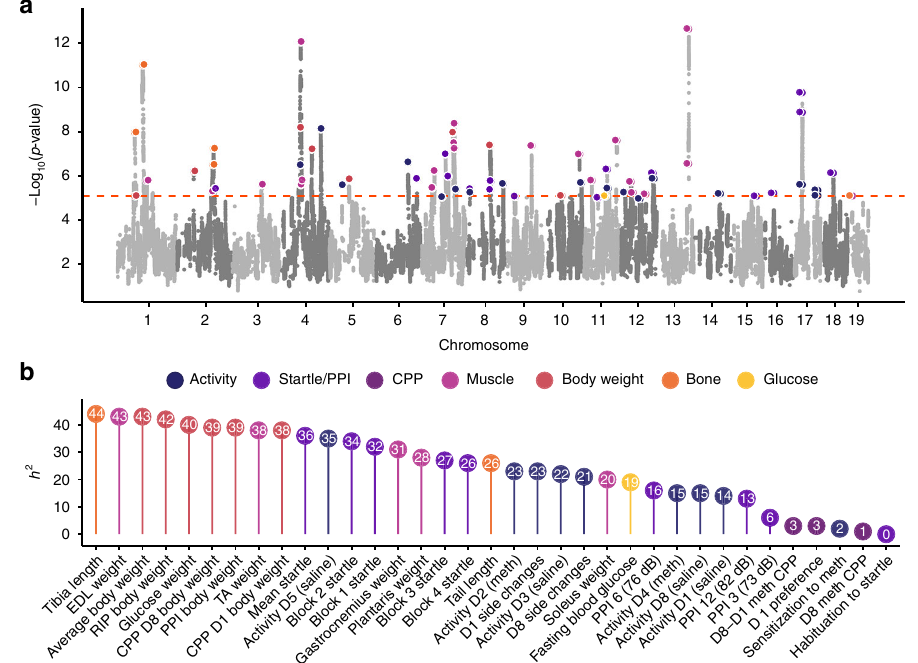
Fig. 3 Manhattan plot and heritability for 120 traits measured in the LG × SM AIL. We identi fi ed 126 loci for behavioral and physiological traits using 1063 mice from G50 – 56 of the LG × SM AIL. A Manhattan plot of GWAS results is shown in ( a ). Associations for related traits are grouped by color. For clarity, related traits that mapped to the same locus (Supplementary Data 1) are highlighted only once. The dashed line indicates a permutation-derived signi fi cance threshold of − log 10 (p) = 5.09 ( p = 8.06 × 10 − 6 ; α = 0.05; likelihood ratio test). b For a representative subset of traits, SNP heritability estimates (percent trait variance explained by 523,028 GWAS SNPs) are shown. Precise estimates of heritability with standard error are provided for